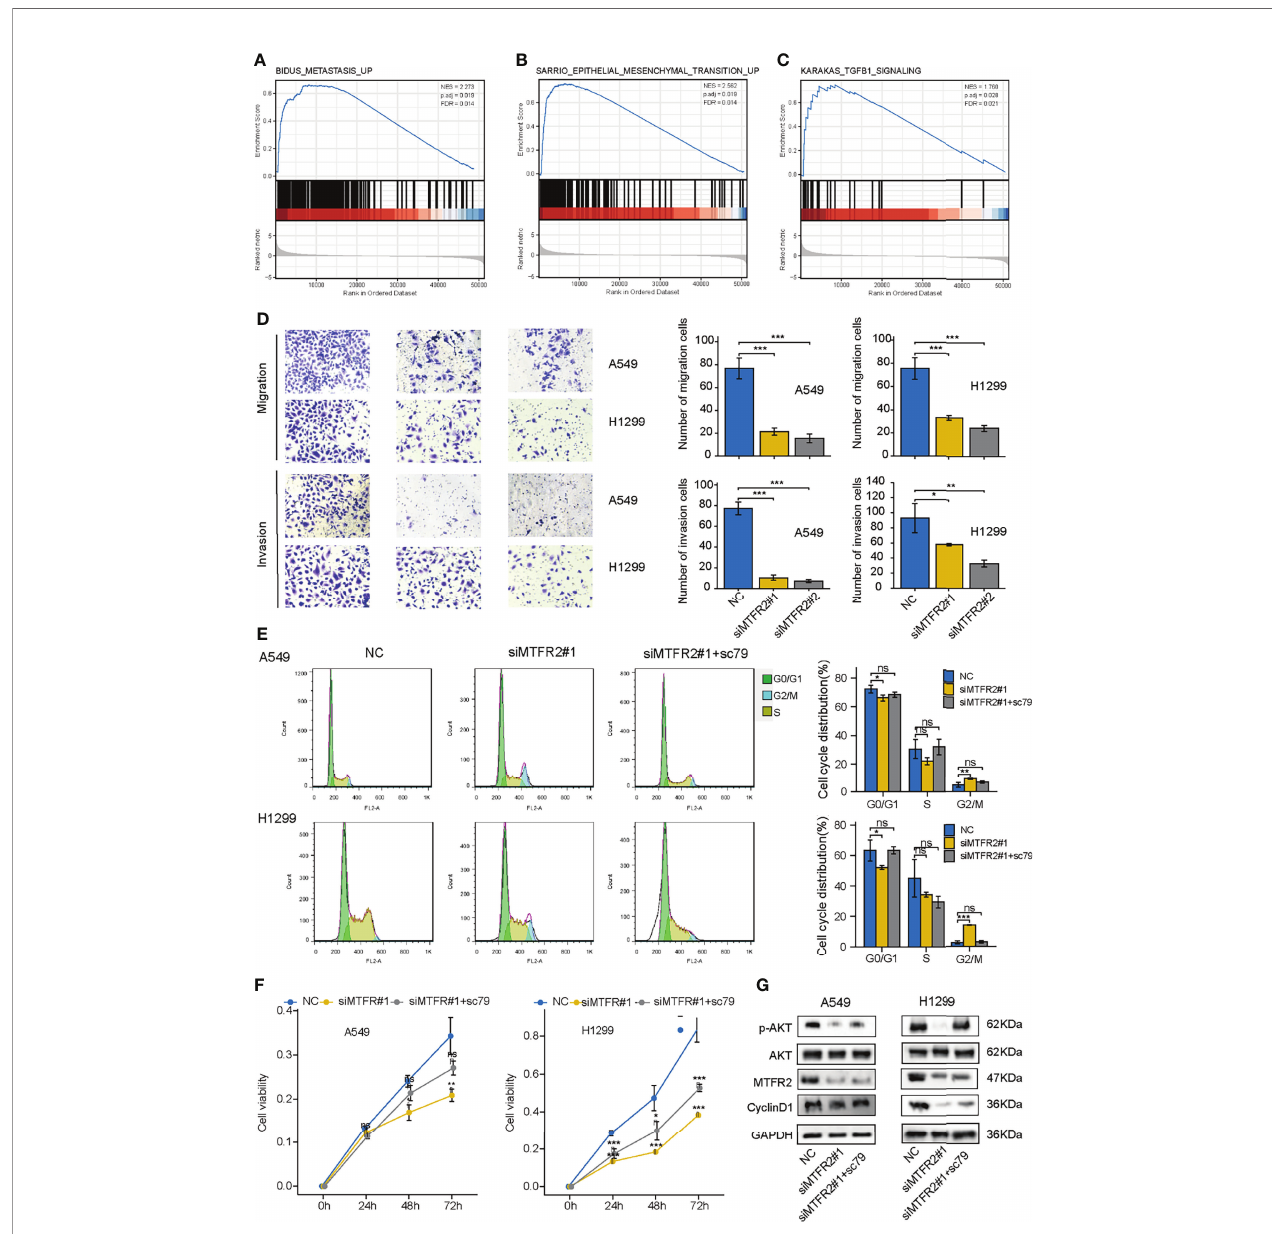
FIGURE 5 | sc79 partly reversed the inhibitory effect after knockdown of MTFR2 in LUAD cells. GSEA analysis showed that MTFR2 overexpression was highly correlated with metastasis (A) , epithelial mesenchymal transition (B) , TGFB1 signaling (C) . Transwell assay revealed that knockdown of MTFR2 could decrease migrated and invasive ability of cancer cells (D) . sc79 could reverse cell cycle arrest (E) and inhibited proliferation (F) caused by knockdown of MTFR2, and relevant protein levels were upregulated (G) . * P < 0.05, ** P < 0.01, *** P < 0.001, ns no statistical signi fi cance. ES, enrichment score; NES, normalized